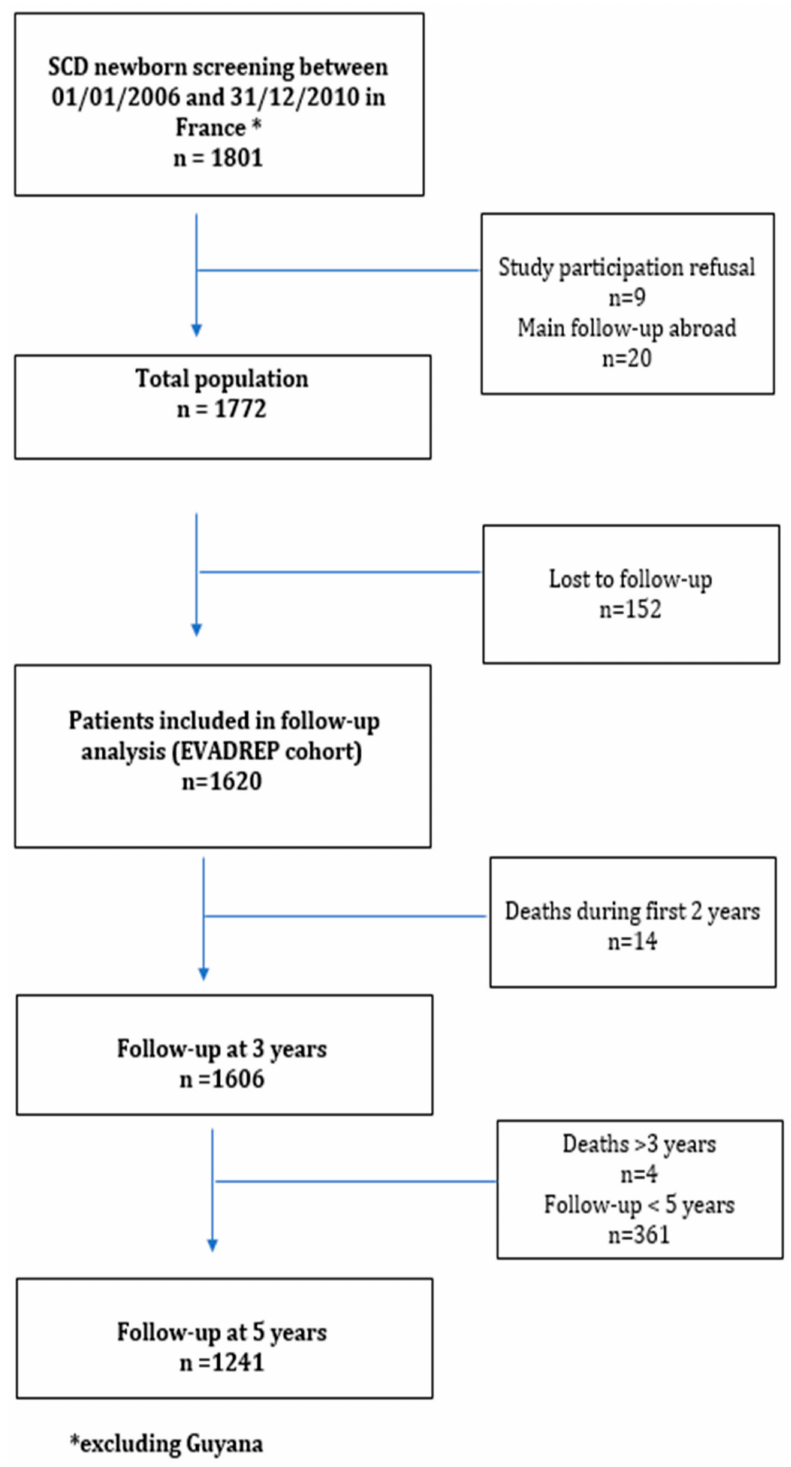
Figure 1. Flow-chart of the